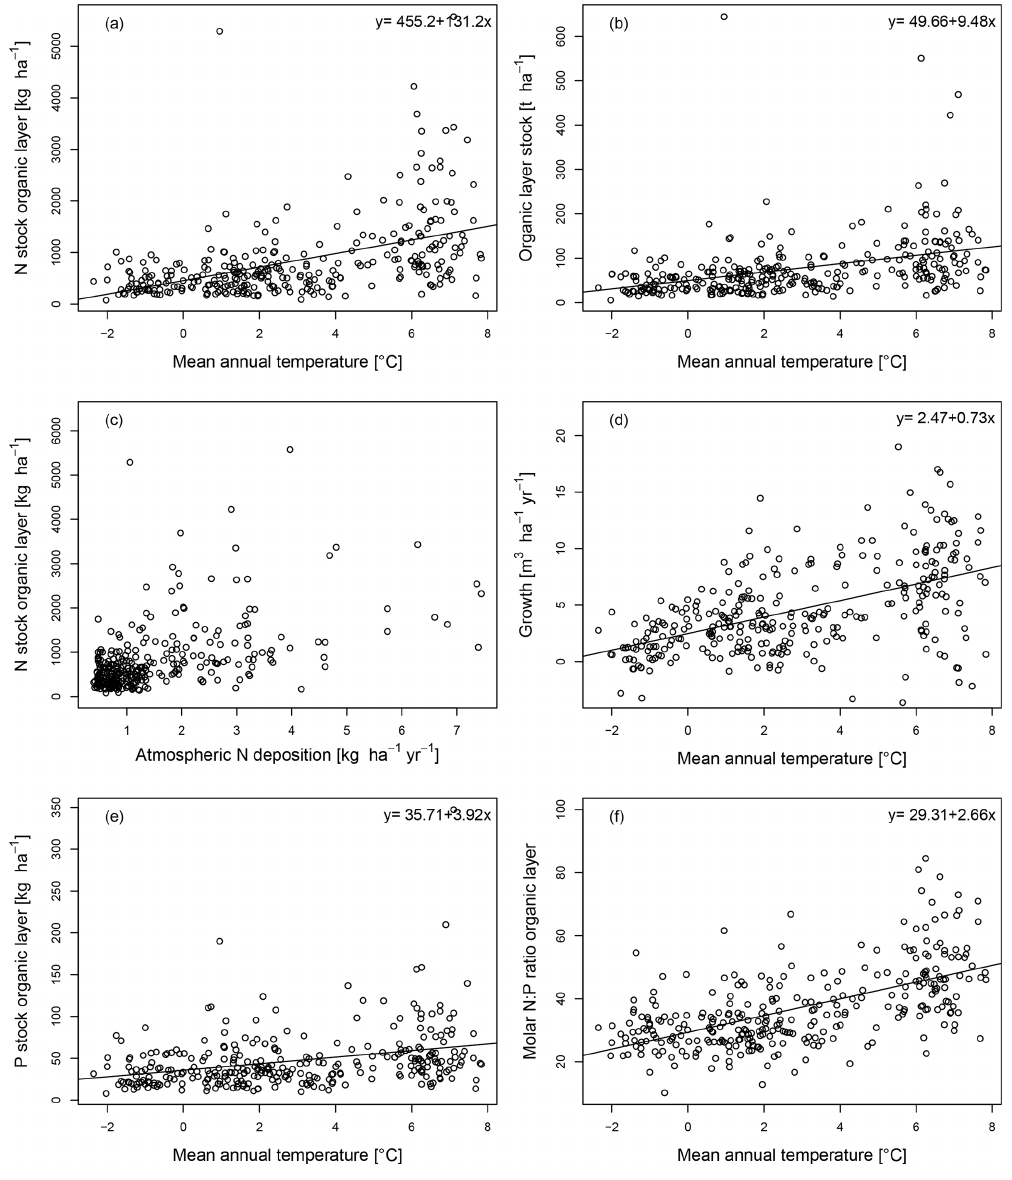
Figure 2. The nitrogen (N) stock of the organic layer (a) and the organic layer stock (b) as a function of mean annual temperature, together with the N stock of the organic layer as a function of atmospheric N deposition (c) , as well as tree stem growth (d) , the P stock of the organic layer (e) , and the molar nitrogen-to-phosphorus (N : P) ratio of the organic layer (f) as a function of mean annual temperature in 309 Swedish forest soils with a stand age > 60